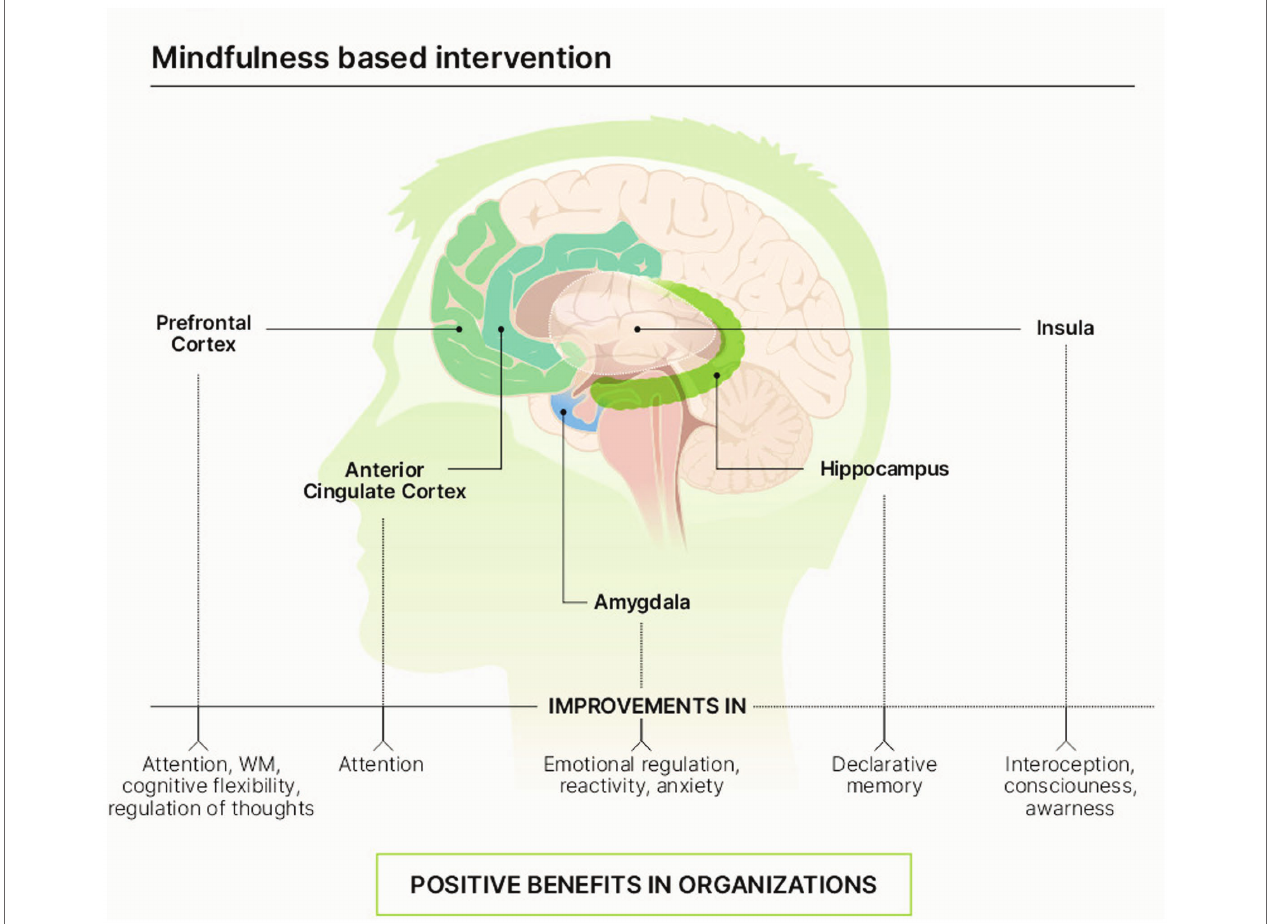
FIGURE 2 | Impact of MBIs on main brain areas, cognitive functions, and affective